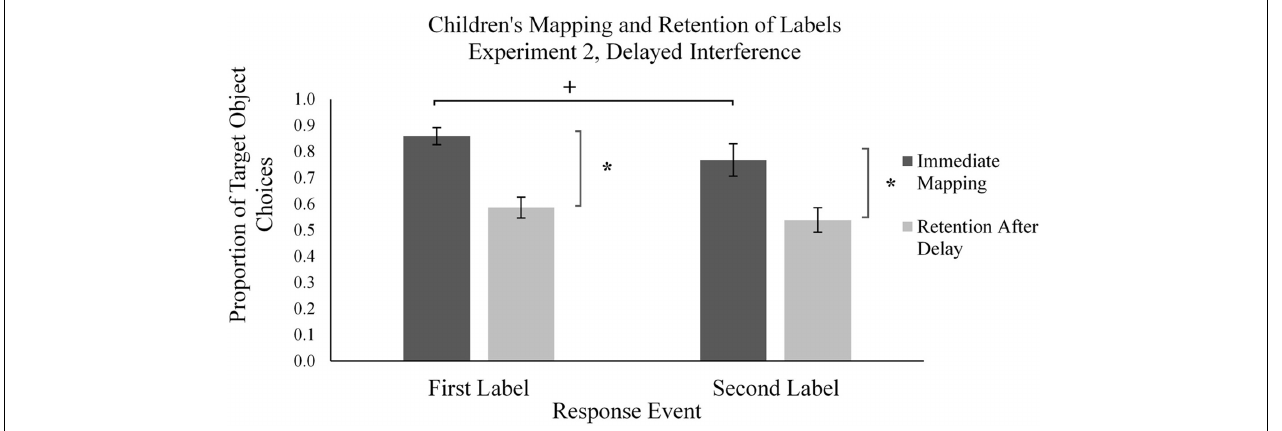
FIGURE 7 | Mean proportion of children’s target novel object choices in the learning phase (immediate mapping) and testing phase (retention after delay) for first and second labels the Delayed Interference condition in Experiment 2. Error bars represent one standard error, * indicates significant difference in performance, p < 0.05, + indicates marginally significant difference in performance, p = 0.06.